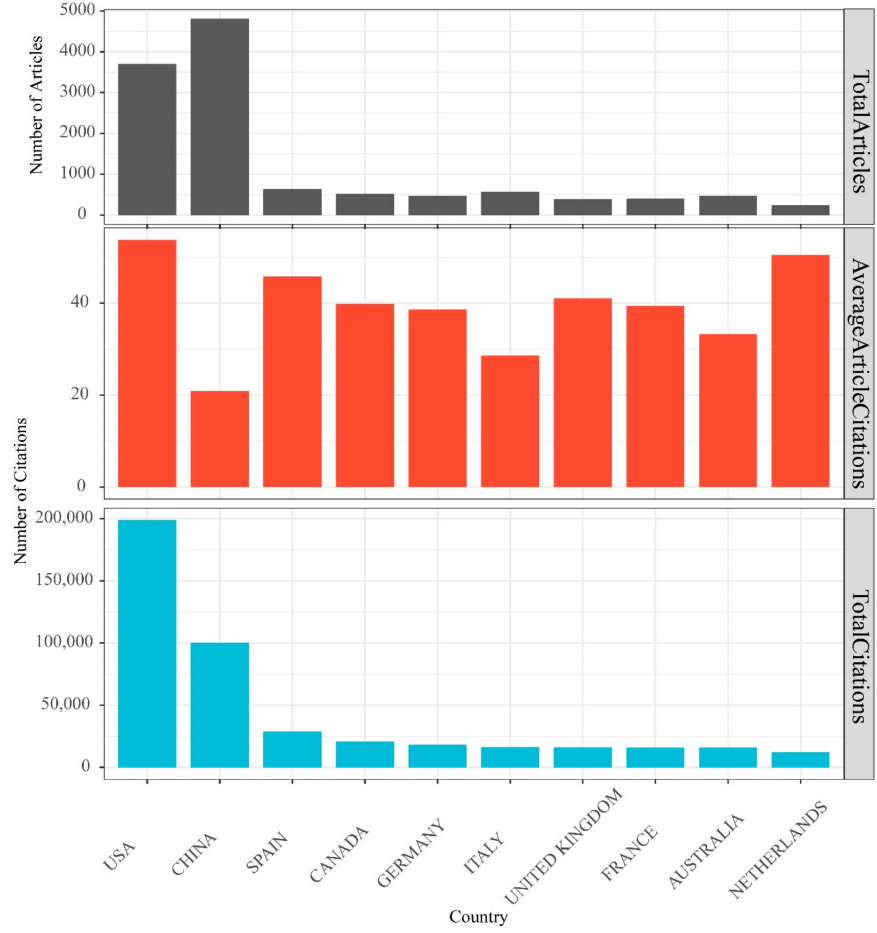
Figure 6. Total Articles, total and average number of citations in the top ten most highly cited countries. Globally, 11,025 institutions have engaged in NDVI research. The influence of each institution was evaluated according to the number of citations of papers published by that research institution, with the top ten institutions according to the total number of citations considered to be the top ten most influential research institutions, which accounted for 591 articles (including first author achievements for each institution). The impact of papers from different institutions varied substantially, with Goddard Space Flight Center, USA, showing the highest number of total citations (18,493), followed by IGSNRR, CAS (5771), University of Arizona (5285), IRSDE, CAS (3651), University of Copenhagen (3024), Peaking University (2915), Beijing Normal University (2698), EROS Data Center (2584),